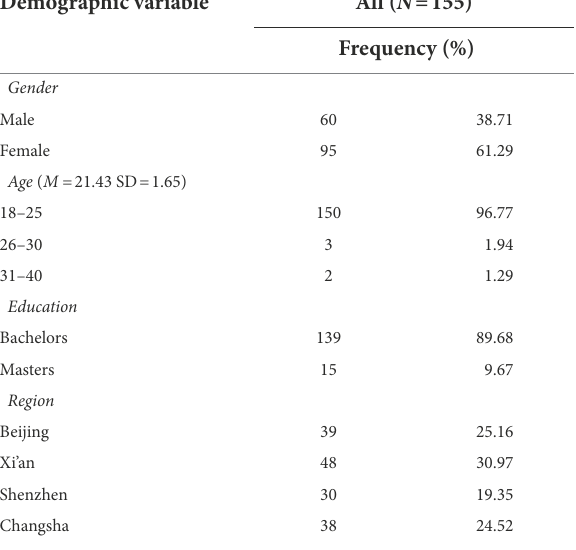
TABLE 3 Profile of